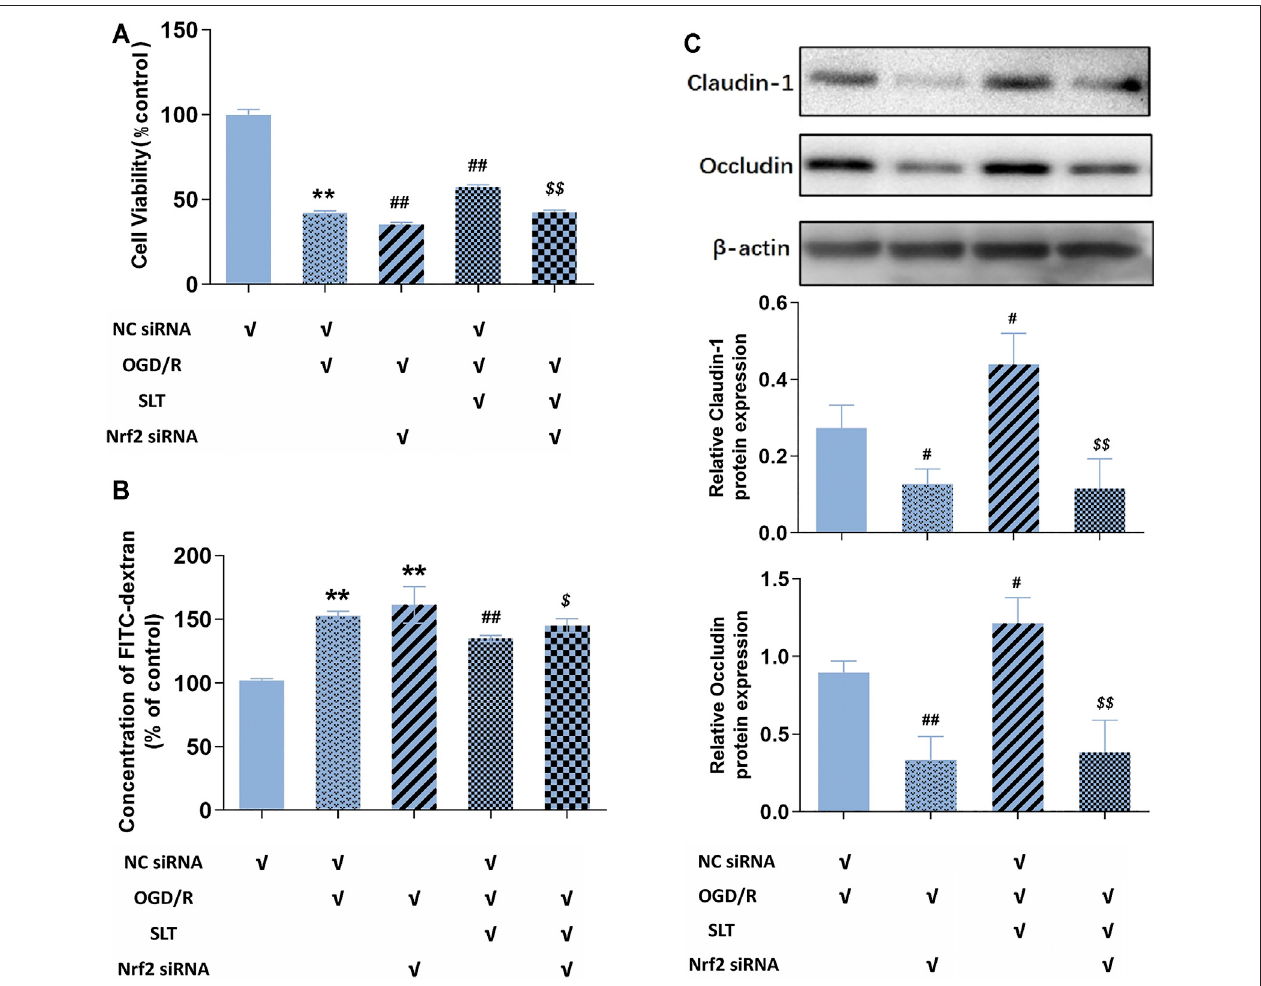
FIGURE 8 | Blocking of the Nrf2 pathway ablated SLT ’ s protection against OGD/R injury in cerebral microvascular endothelial cells. (A,B) Effects Nrf2 siRNA interference on SLT ’ s ameliorations on cell viabilities and FITC-dextran permeabilities in OGD/R-injured hCMEC/D3 cells ( n (cid:1) 6). (C) Effects of Nrf2 siRNA interference with SLT ’ s ameliorations on claudin-1 and occludin expressions in OGD/R-injured hCMEC/D3 cells ( n (cid:1) 3). Data are expressed as mean ± SD. * p < 0.05, ** p < 0.01, vs. negative control siRNA (NC siRNA) group; # p < 0.05, ## p < 0.01, vs. NC siRNA + OGD/R group; $ p < 0.05, $$ p < 0.01, vs. NC siRNA + OGD/R + SLT group.